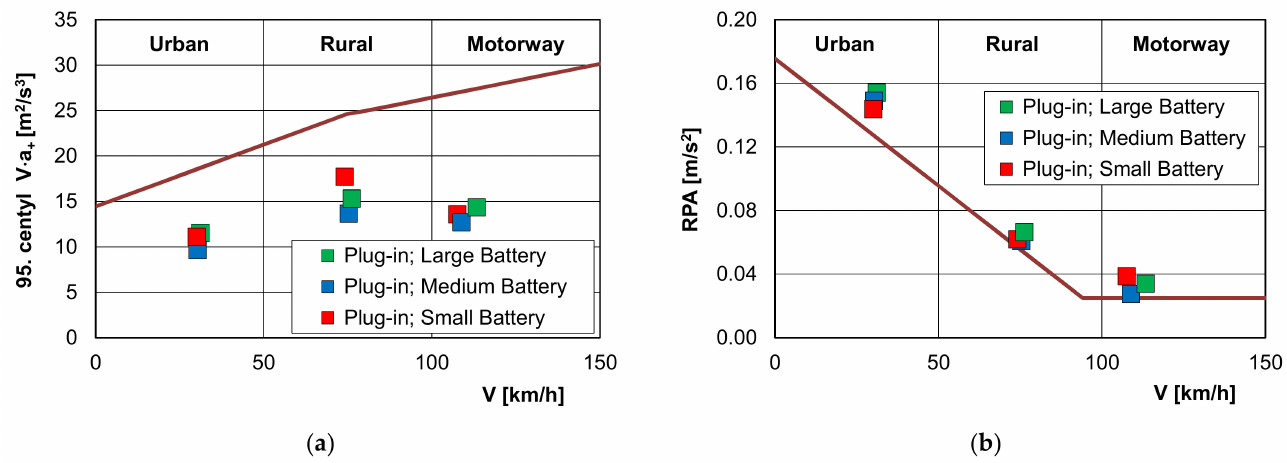
Figure 4. Comparison of the 95% centile of the product of vehicle speed and positive acceleration ( a ) and the relative positive acceleration ( b ) in each phase of the test performed on the plug-in